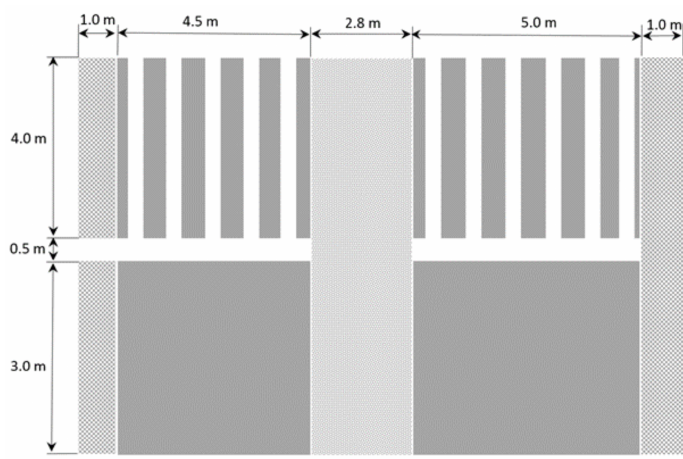
Figure A3. Basic dimensions of pedestrian crossing no.